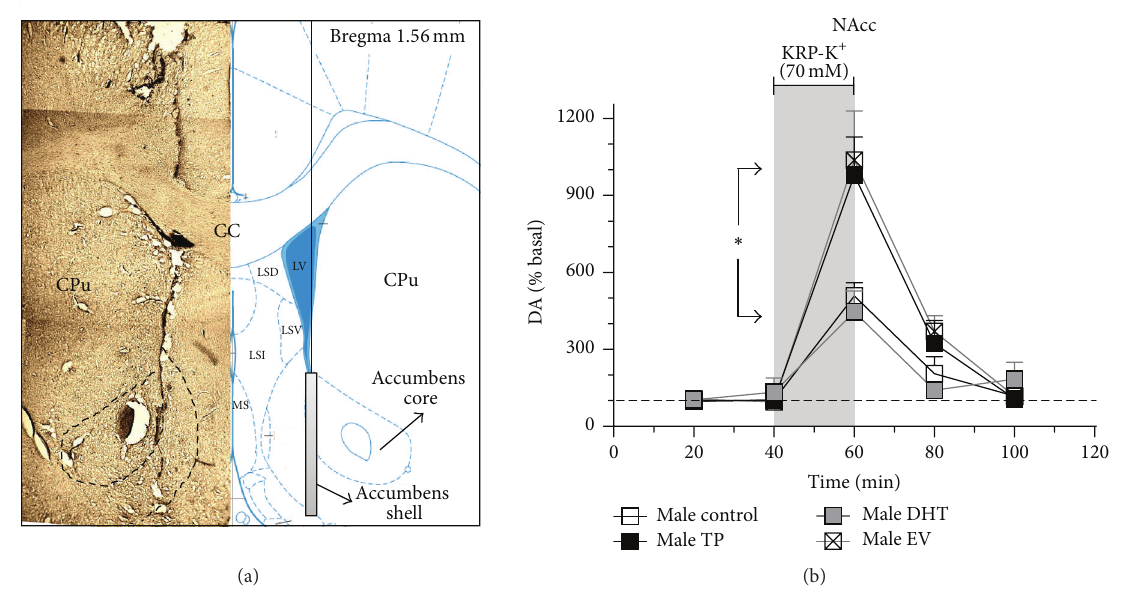
Figure 5: Dopamine release in nucleus accumbens (NAcc) of adult male with neonatal exposure to testosterone propionate (TP), dihydrotestosterone (DHT), or estradiol valerate (EV). Panel (a) (left) shows a typical placement of microdialysis probe in NAcc. Panel (a) (right) shows a scheme of NAcc extracted from the rat brain atlas [41] with an example of the theoretical probe position. Panel (b) shows extracellular dopamine levels in the NAcc and the grey bar indicates the time during which Krebs-Ringer’s phosphate (KRP) buffer-K + [70 mM] was perfused. Asterisk indicates a significant difference when comparing the effect of KRP-K + between the respective experimental groups ( ∗ 𝑃 < 0.05 ; one-way ANOVA followed by the Newman-Keuls multiple comparison test). Results are expressed as percentage of the respective basal levels (mean) ± SEM ( 𝑛 = 6 for male control and 𝑛 = 5 for each treatment group). MS, medial septum; LSI, lateral septum intermediate; LSV, lateral septum ventral; LSD, lateral septum dorsal; cc, corpus callosum; LV, lateral ventricle; CPu, caudate